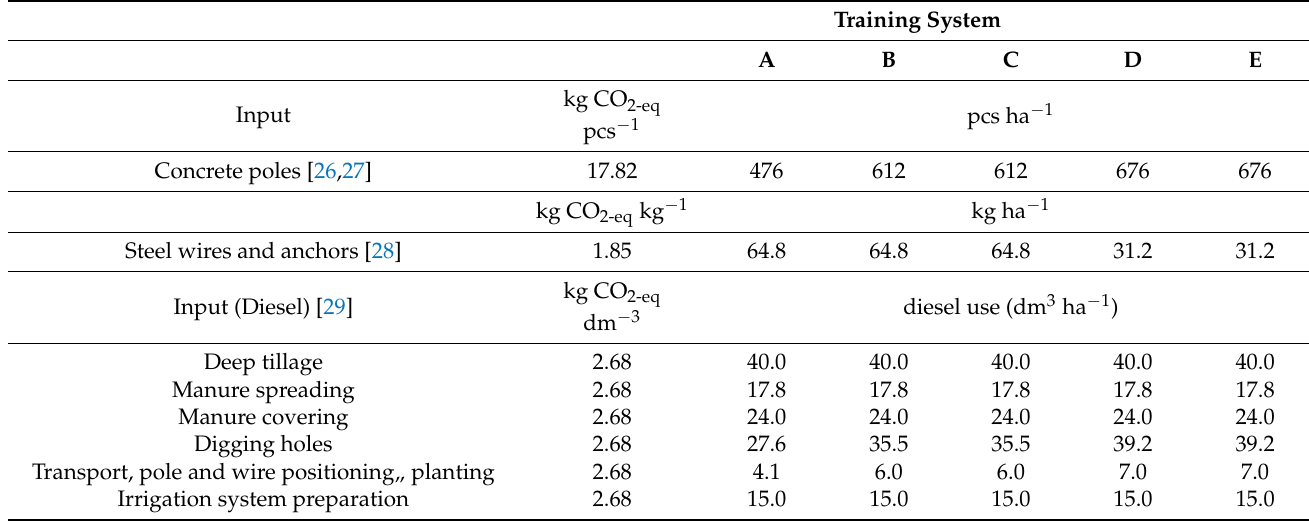
Table 4. Input data for vineyard planting.